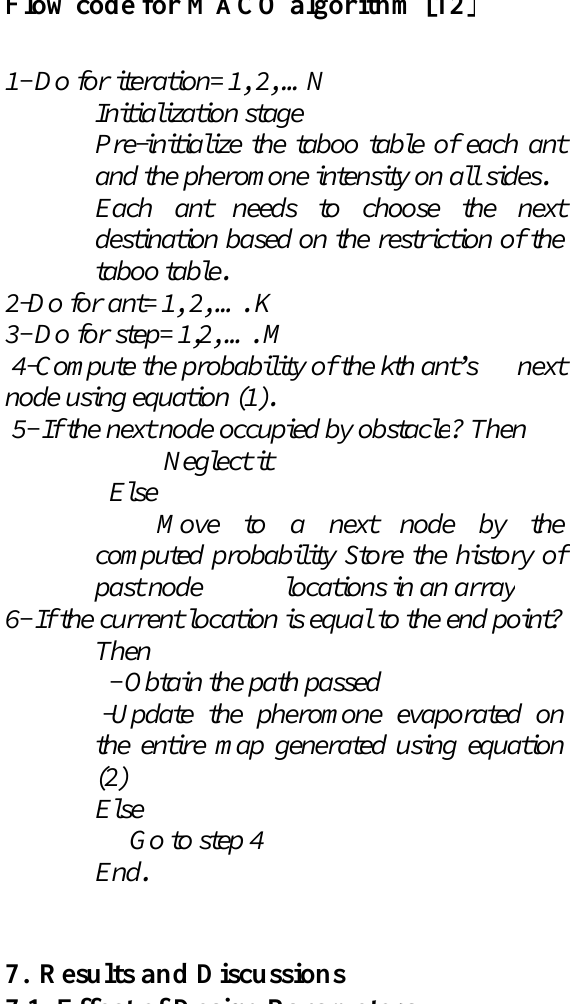
algorithm finds an